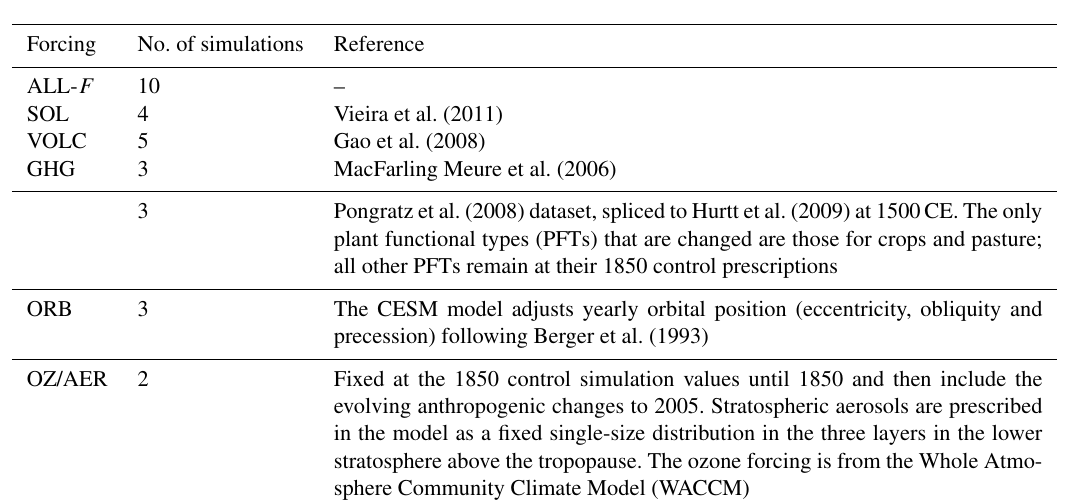
Table 2. Simulations and LM external forcing reconstructions used in CESM-LME. The single-forcing simulations cover from 850 to 2005CE except for those of anthropogenic ozone and aerosols that span the period from 1850 to 2005CE. The legend for external forcing is as follows: SOL represents changes in total solar irradiance; VOLC represents volcanic activity; GHG represents concentrations of the well-mixed greenhouse gases CO 2 , CH 2 and N 2 O; LULC represents land use land cover changes; ORB represents orbital variations; and OZ/AER represents anthropogenic ozone and aerosols.